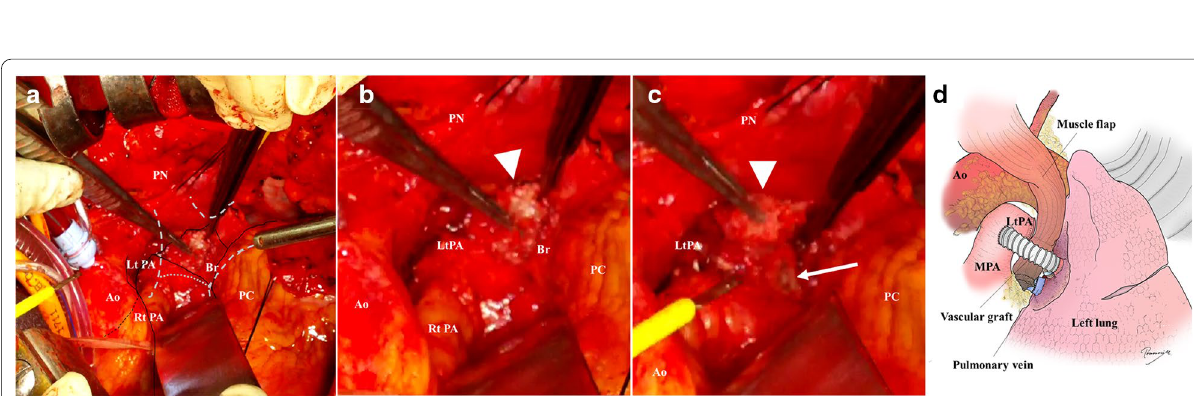
Fig. 3 Intraoperative photos and illustrations of the hilar structures and reconstructed pulmonary artery. a An intraoperative picture showing the hilar structure; this picture was captured from the head camera of the operator standing on right side of the patient. The outline of left bronchus and bronchial anastomosis are illustrated as dashed lines and dotted lines, respectively. Note that the left pulmonary artery was exposed inside the pericardium and tracked peripherally toward the left hilum. Only a part of the bronchus distal to the bronchial anastomosis was exposed. b An enlarged picture of a showing a foreign body (white arrowhead) that appeared to be embedded in the bronchial wall. c Removal of the foreign body revealed a bronchial fistula (a white arrow). d An illustration of left pulmonary artery reconstructed using vascular prosthesis. Ao aorta, LtPA left pulmonary artery, RtPA right pulmonary artery, Br bronchus, PN phrenic nerve, PC pericardial tissue, MPA main pulmonary